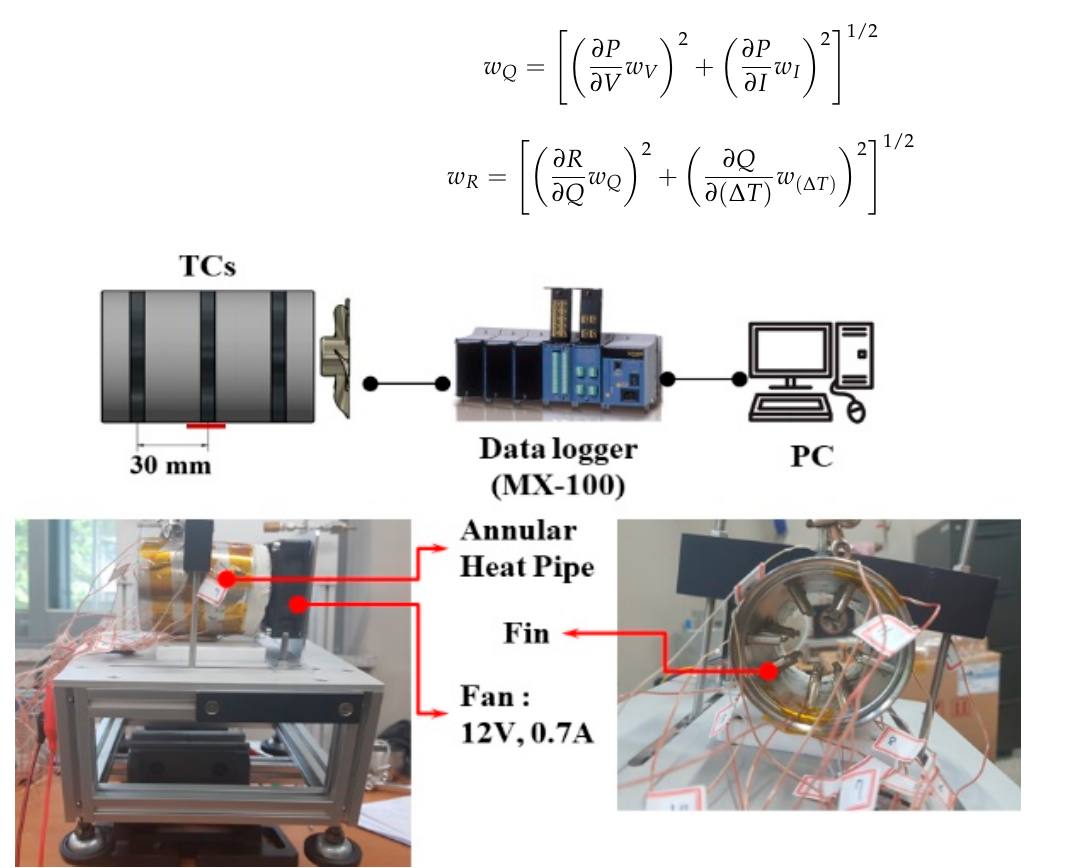
Figure 5. Experimental equipment of the CAHP.